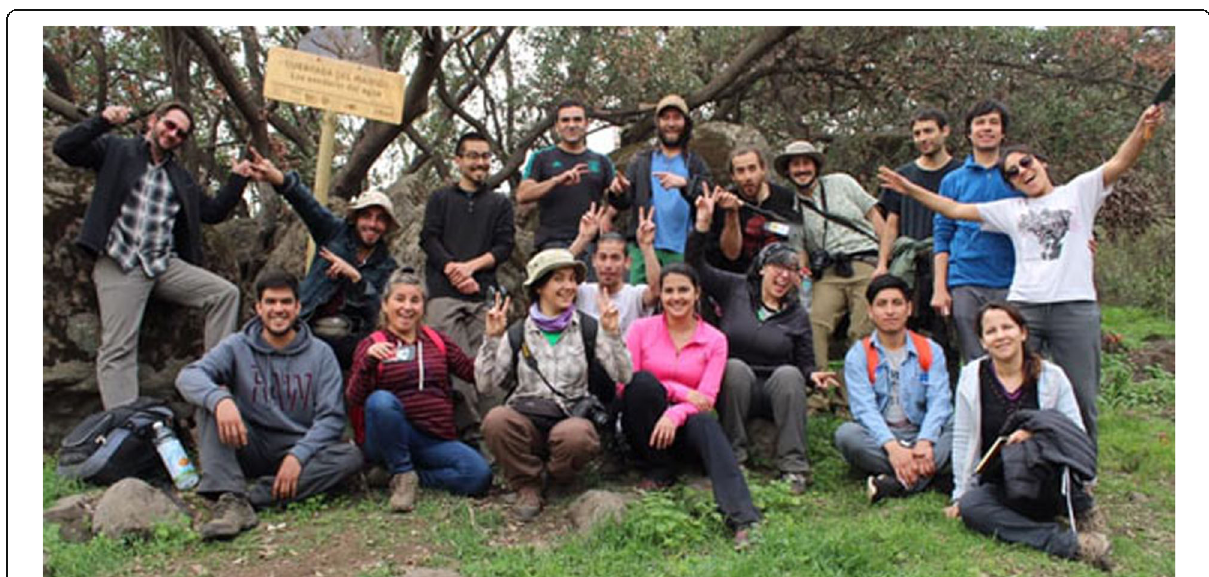
Fig. 8 Participants in the pre-meeting course “ Introduction to mycorrhizas of the Chilean sclerophyllous forest